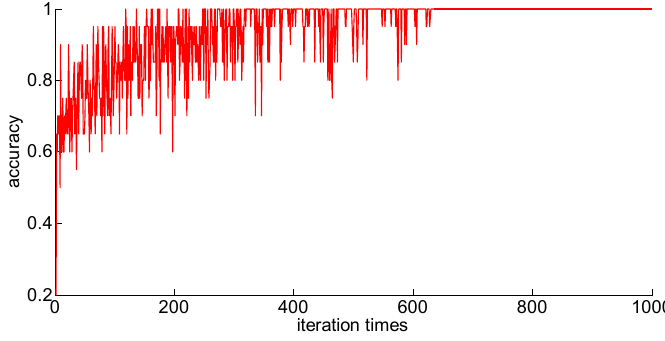
Figure 12. One hundred training samples of the neural network.